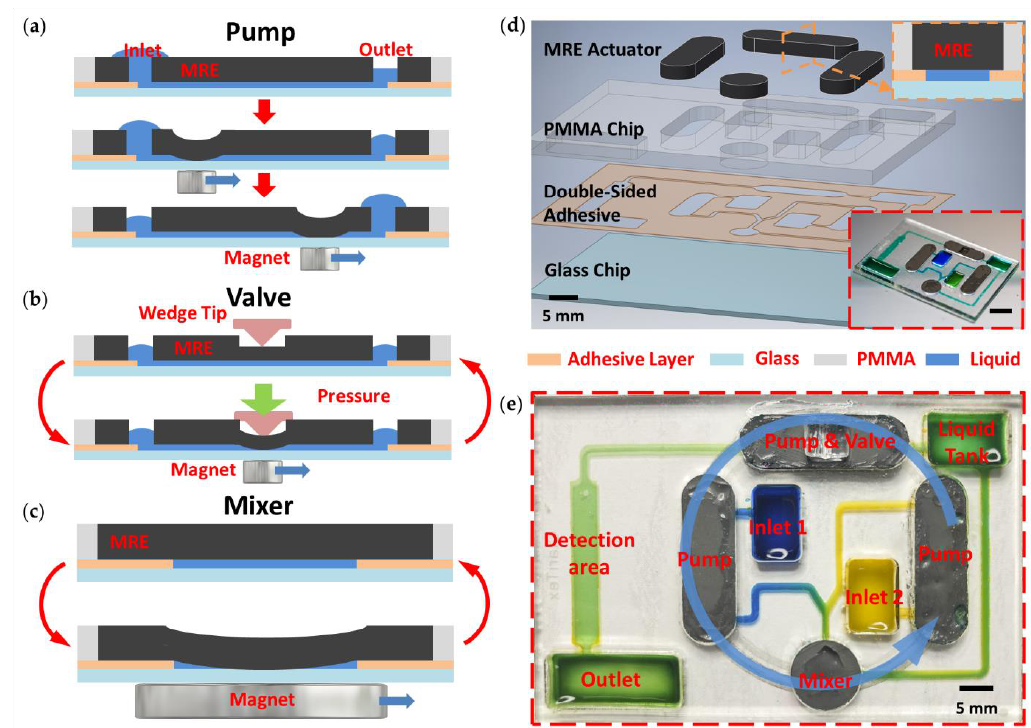
Figure 2. Schematic illustration of the microfluidic chip design and the working principle of MRE actuators. Schematic of the working mechanism of a MRE ( a ) micropump, ( b ) microvalve and ( c ) micromixer. ( d ) Exploded schematic representation of one design of the MRE microfluidic chip. The upper insert illustrates the cross-sectional view for a MRE actuator. The lower inset shows actual image of an assembled chip (Scale bar = 10 mm). ( e ) Actual image of the assembled chip integrated with three MRE pumps, one mixer and one valve.